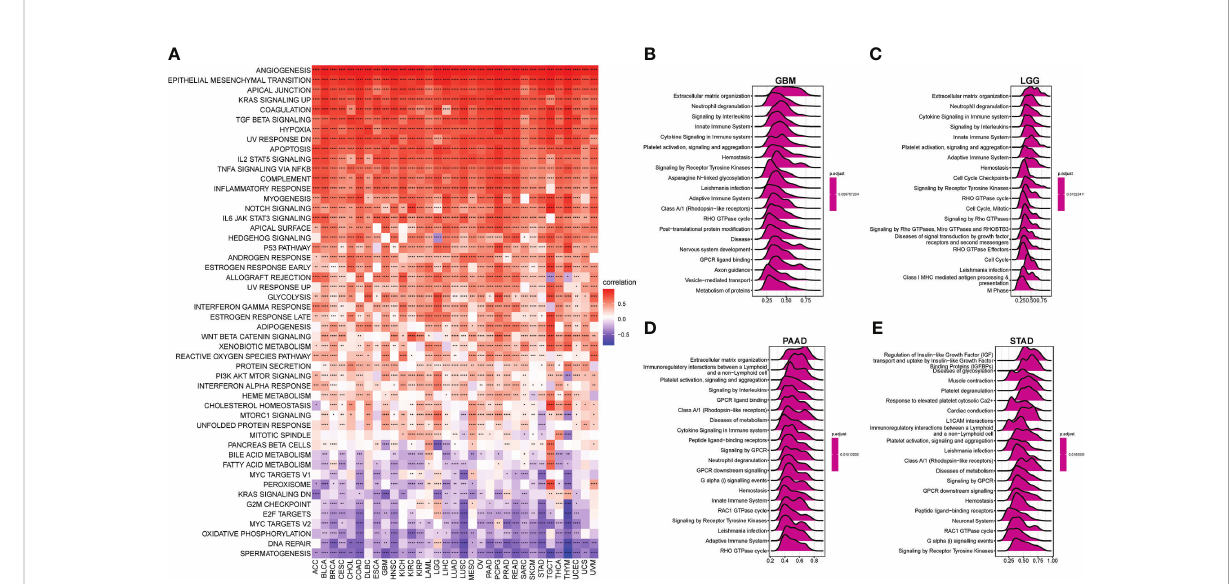
FIGURE 5 Gene set variation analysis (GSVA) and gene set enrichment analysis (GSEA) of the AR score. (A) The heatmap represents the correlation between the AR score and 50 HALLMARK pathways in pan-cancer. And the top 20 signi fi cant terms of GSEA results in (B) Glioblastoma (GBM),